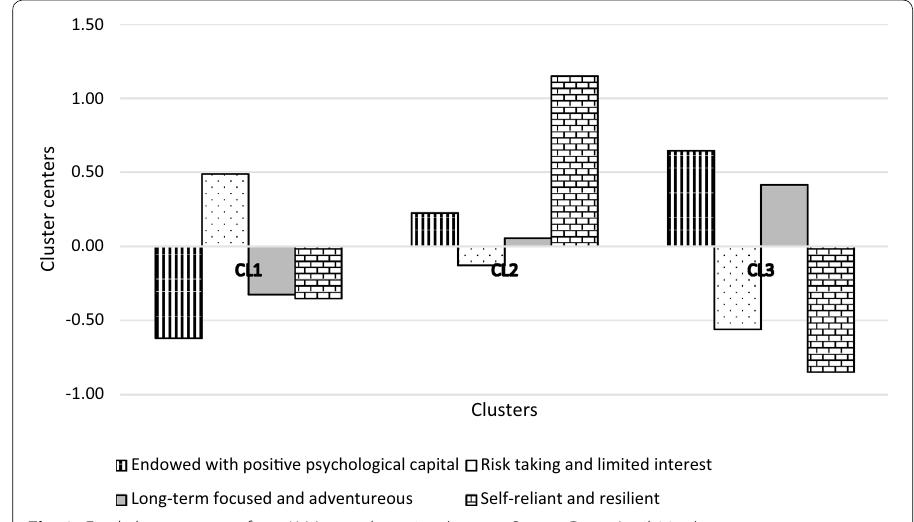
Fig. 2 Final cluster centres from K-Means clustering (source: Survey Data, April 2017)